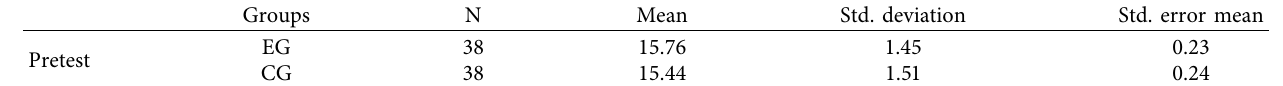
Table 2: Descriptive statistics for the pretest.